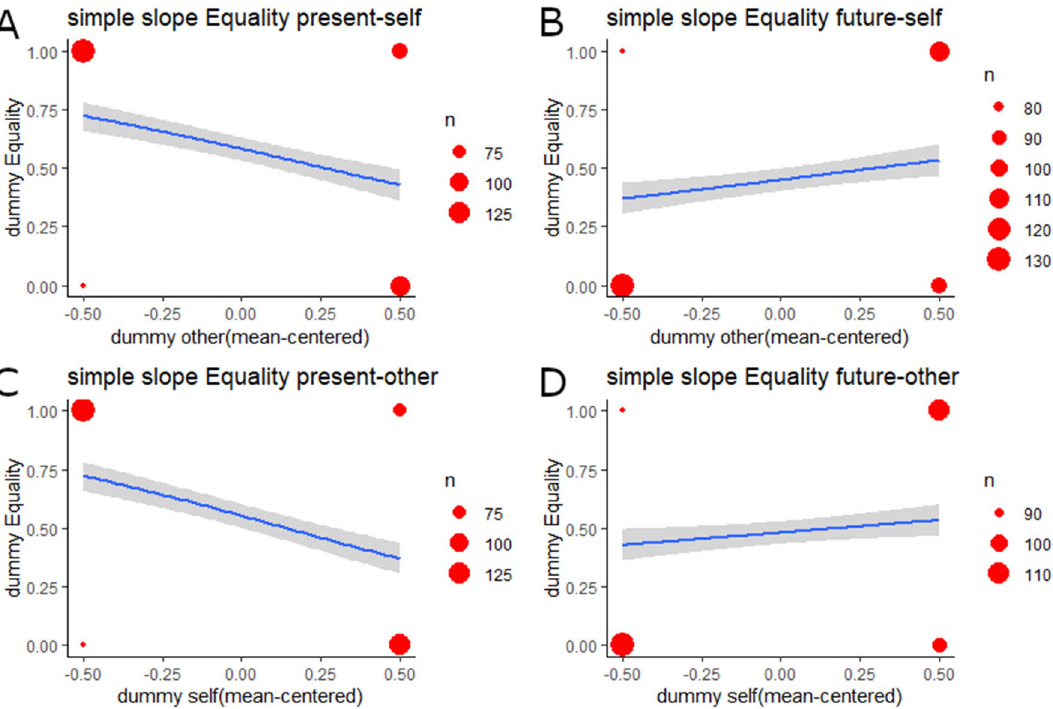
Figure 2. Results of simple slope analyses for Equality preference. Size of the red dots indicates sample size. Blue lines are regression lines, and gray-colored areas indicate 95% confidence intervals. ( A ) Simple effects of other condition in the present-self condition (self dummy = 0). ( B ) Simple effects of other condition in the future-self condition (self dummy = 1). ( C ) Simple effects of self condition in the present-other condition (other dummy = 0). ( D ) Simple effects of self condition in the future-other condition (other dummy = 1). This figure was drawn using the ggplot2 package 53 (ver. 3.2.0) for R.